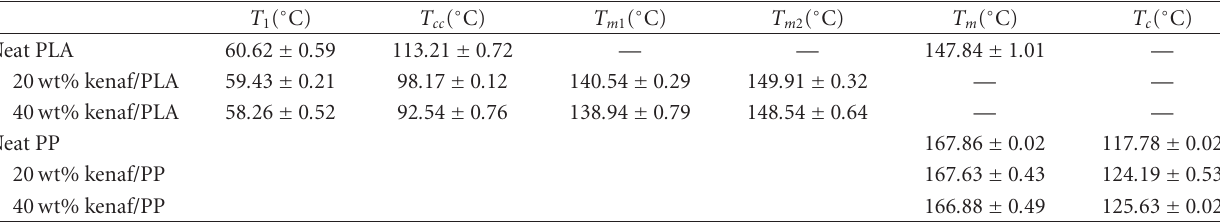
Figure 2: SEM micrographs of cry-fractured surface of (a) PLA, (b) PP, (c) 20 wt% kenaf/PLA, (d) 20 wt% kenaf/PP, (e) 30 wt% kenaf/PLA, and (f) 30 wt% kenaf/PP composites. Table 2: Peak temperatures of the neat PLA, PP and their